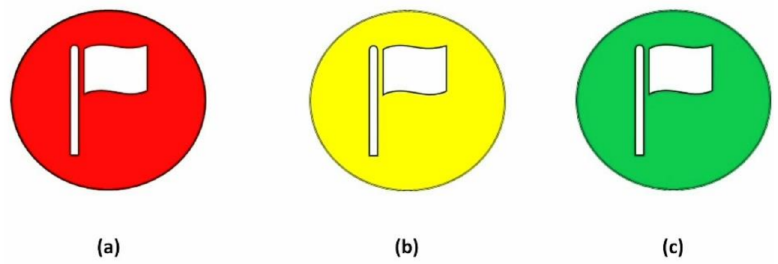
Figure 3. Flag symbols of the tsunami road signs used for the self-evacuation map: ( a ) red for the hazard zone; ( b ) yellow for evacuation routes; and ( c ) green for assembly points (see also Figure 4). Signage symbols by Dr. Orna Ido-Lichtman, Israel’s National Steering Committee for Earthquake